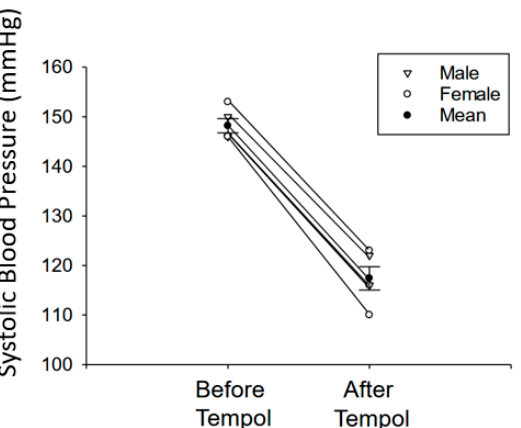
Figure 1. Blood pressure of hypertensive 129Sv mice before and after Tempol infusion. Systolic blood pressures of salt-induced hypertensive 129Sv mice before and after Tempol infusion measured by the tail-cuff method. N = 5 mice per group. A paired t-test was performed using the raw data. p = 0.063. Male mice and female mice were denoted by different symbols as indicated in the key.